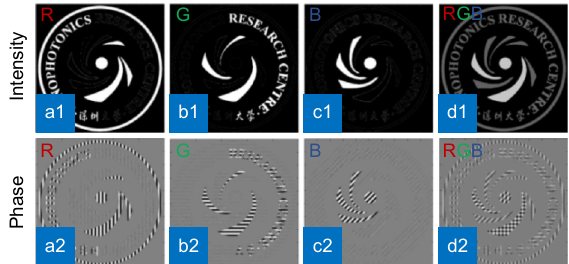
Fig. 2 | Amplitude and phase mask generation process. ( a1 ) Amplitude modulation mask for red. ( b1 ) Amplitude modulation mask for green. ( c1 ) Amplitude modulation mask for blue, where the amp- litude modulation range is 0–1. ( d1 ) Amplitude modulation mask for tri-primary color amplitude linear superposition, which can be loaded by the DMD. ( a2 ) Phase modulation mask for red, loading a vertical blazed grating. ( b2 ) Phase modulation mask for green, loading a ho- rizontal blazed grating. ( c2 ) Phase modulation mask for blue, load- ing a 45° tilted blazed grating, where the phase modulation range is (0,2π). ( d2 ) Phase modulation mask for tri-primary color phase lin- ear superposition, which can be loaded by the